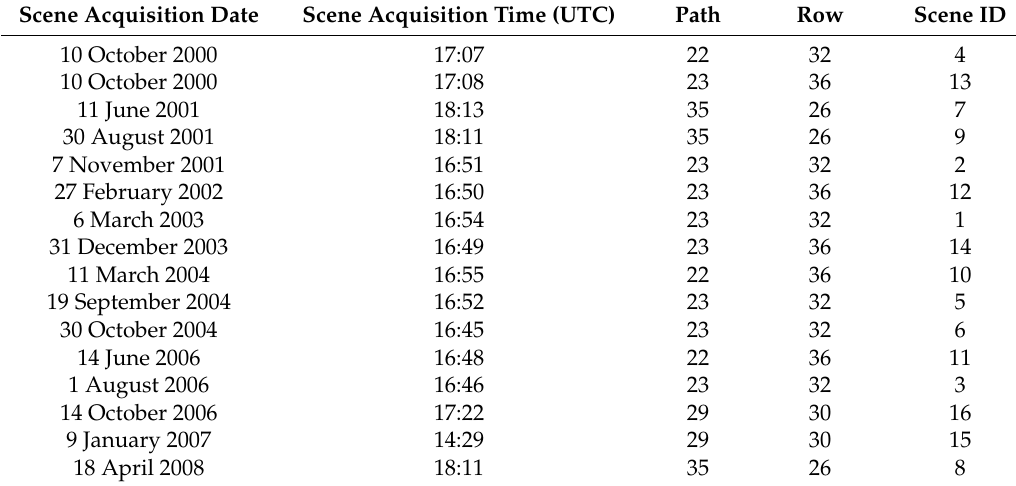
Table 2. ASTER scenes used in the